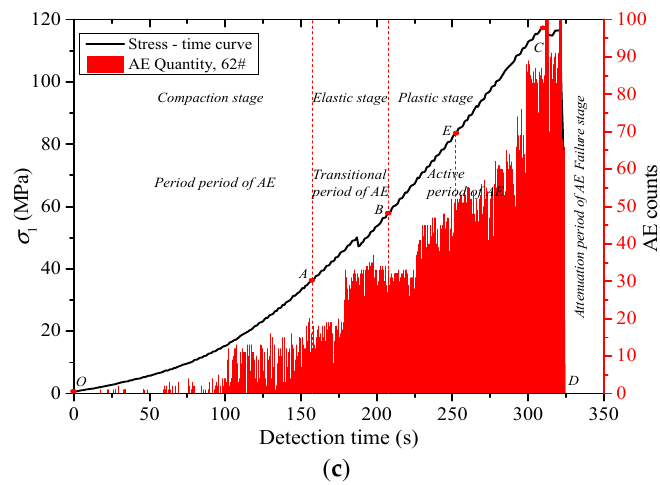
Figure 3. Stress–time–acoustic–AE curves in uniaxial compression test of the three types of rocks. ( a ) Red sandstone; ( b ) marble; ( c ) granite.